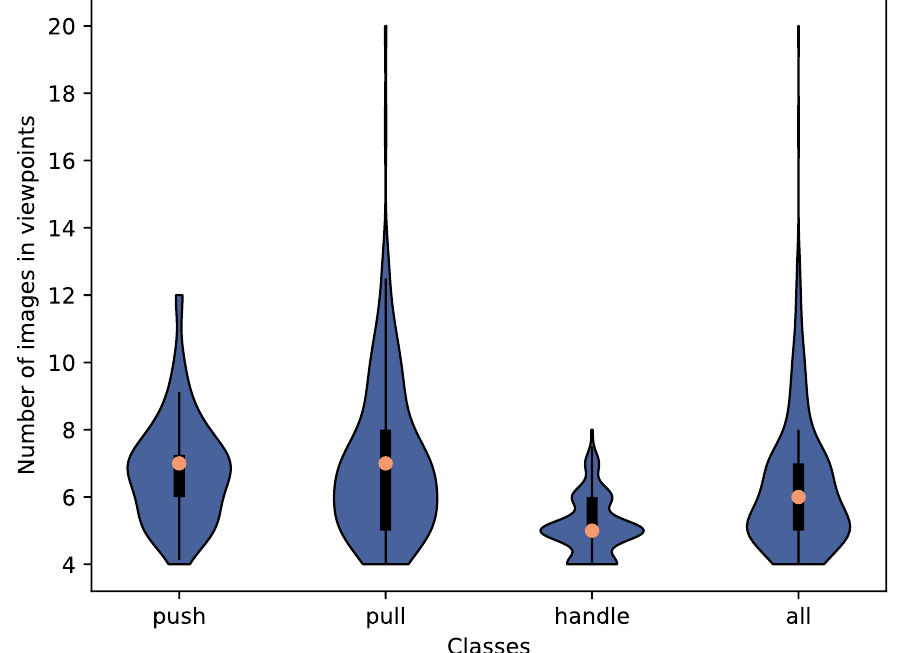
Figure 6. Distribution of images in the viewpoints per class and